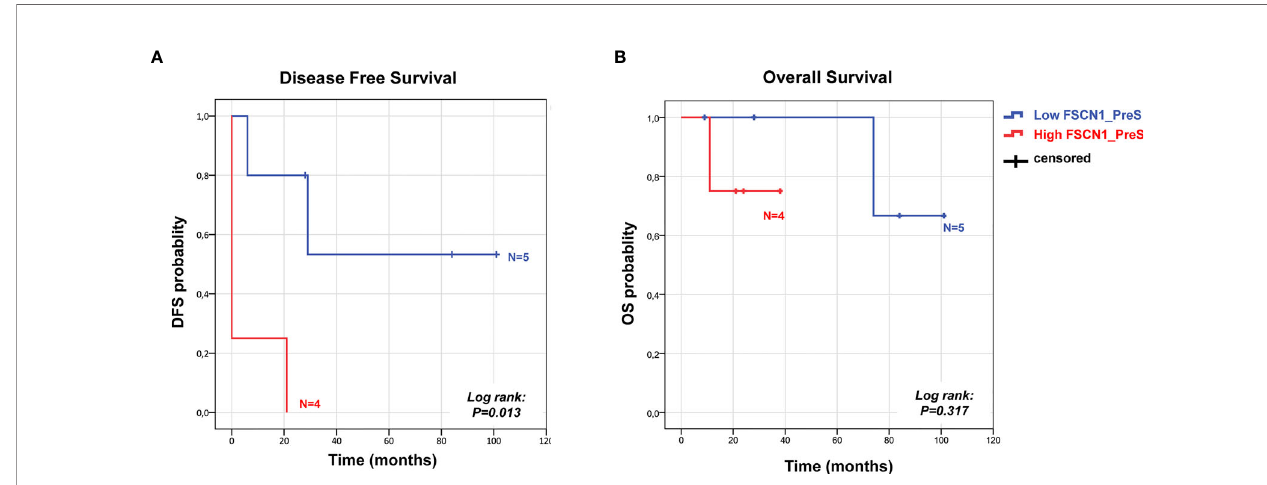
FIGURE 3 | Survival predictive power of pre-surgery serum FSCN1 levels in ACC. Kaplan Meier analysis of DFS (A) and OS (B) in n=9 ACC patients strati fi ed in two classes according to low and high FSCN1 preS serum concentrations (cut off=21.49 ng/ml, pre-surgery FSCN1 median value). Statistical signi fi cance is indicated by